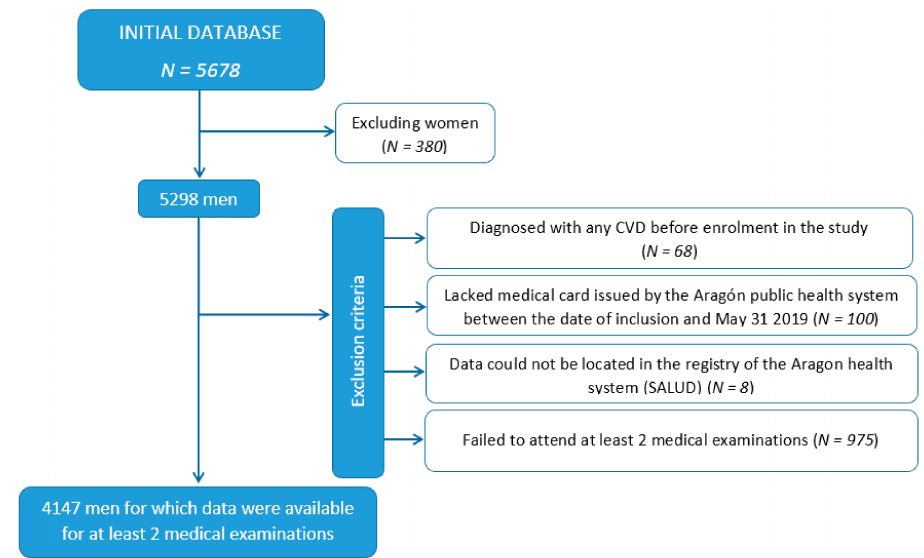
Figure 1. Flowchart depicting the study